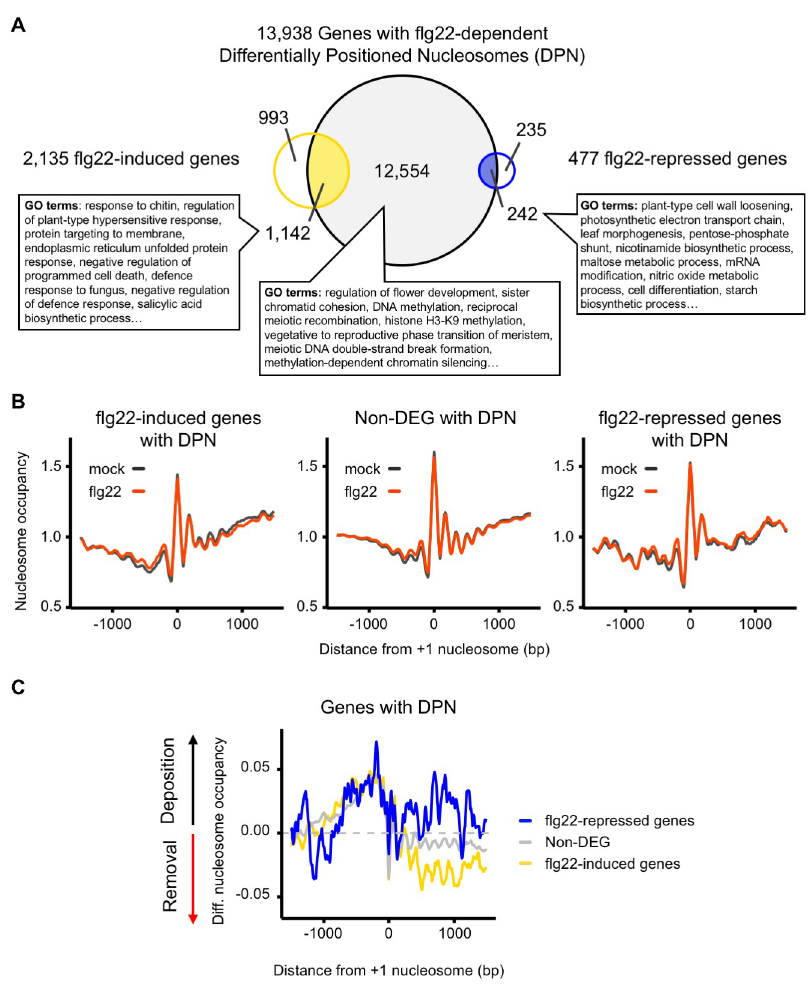
Fig 1. Activation of MTI results in nucleosome repositioning that correlates with gene expression. (A) flg22 elicitation results in Differentially Positioned Nucleosomes (DPN). 2-week-old Col-0 seedlings were treated for 2 hours with 100 nM flg22 before harvesting for RNA-seq and MNase-seq analysis. Venn diagram illustrating the overlap between genes (protein-coding genes plus 1000 nucleotides upstream their Transcription Start Sites, TSS) with at least one DPN (grey), flg22-induced genes (yellow), and flg22-respressed genes (blue). Most significant GO terms found for the intersection groups with the TopGO package using as a control set all Arabidopsis protein coding genes (Fisher Exact Test, p-value < 0.01). (B) Changes in nucleosome occupancy in the promoters and the gene bodies following flg22 elicitation. Average nucleosome occupancy detected with MNase-seq analysis, mock (black) and flg22 (red) for flg22-induced genes with DPNs (left panel), Non-Differentially Expressed Genes (Non-DEGs) with DPNs (middle panel) and flg22-repressed genes (right panel). Graphs are centred on the +1 nucleosome from the gene TSS. (C) Differential nucleosome occupancy following flg22 elicitation. Average of the nucleosome occupancy differences between flg22- and mock treatment of flg22-induced (yellow), Non-DEGs (grey), and flg22-repressed genes (blue) for genes with DPN. The graph is centred on the +1 nucleosome from the gene TSS. attention to uncharacterized genes or those not yet associated with plant immunity (Tables 1 and S4). Five-week-old homozygous T-DNA insertion mutant plants were spray-inoculated with a Pseudomonas syringae pathovar tomato DC3000 ( Pst DC3000) strain lacking the effec- tors AvrPto and AvrPtoB ( Pst DC3000 Δ avrPto Δ avrPtoB ) in order to discern milder pheno- types. Of the 20 chromatin remodeling ATPase mutants tested, six showed altered immune responses (Table 1). In comparison with Col-0 control plants, PICKLE RELATED 2 ( PKR2 , also known as CHR7 ) and RAD54 (also known as CHR25 ) mutants were more susceptible to